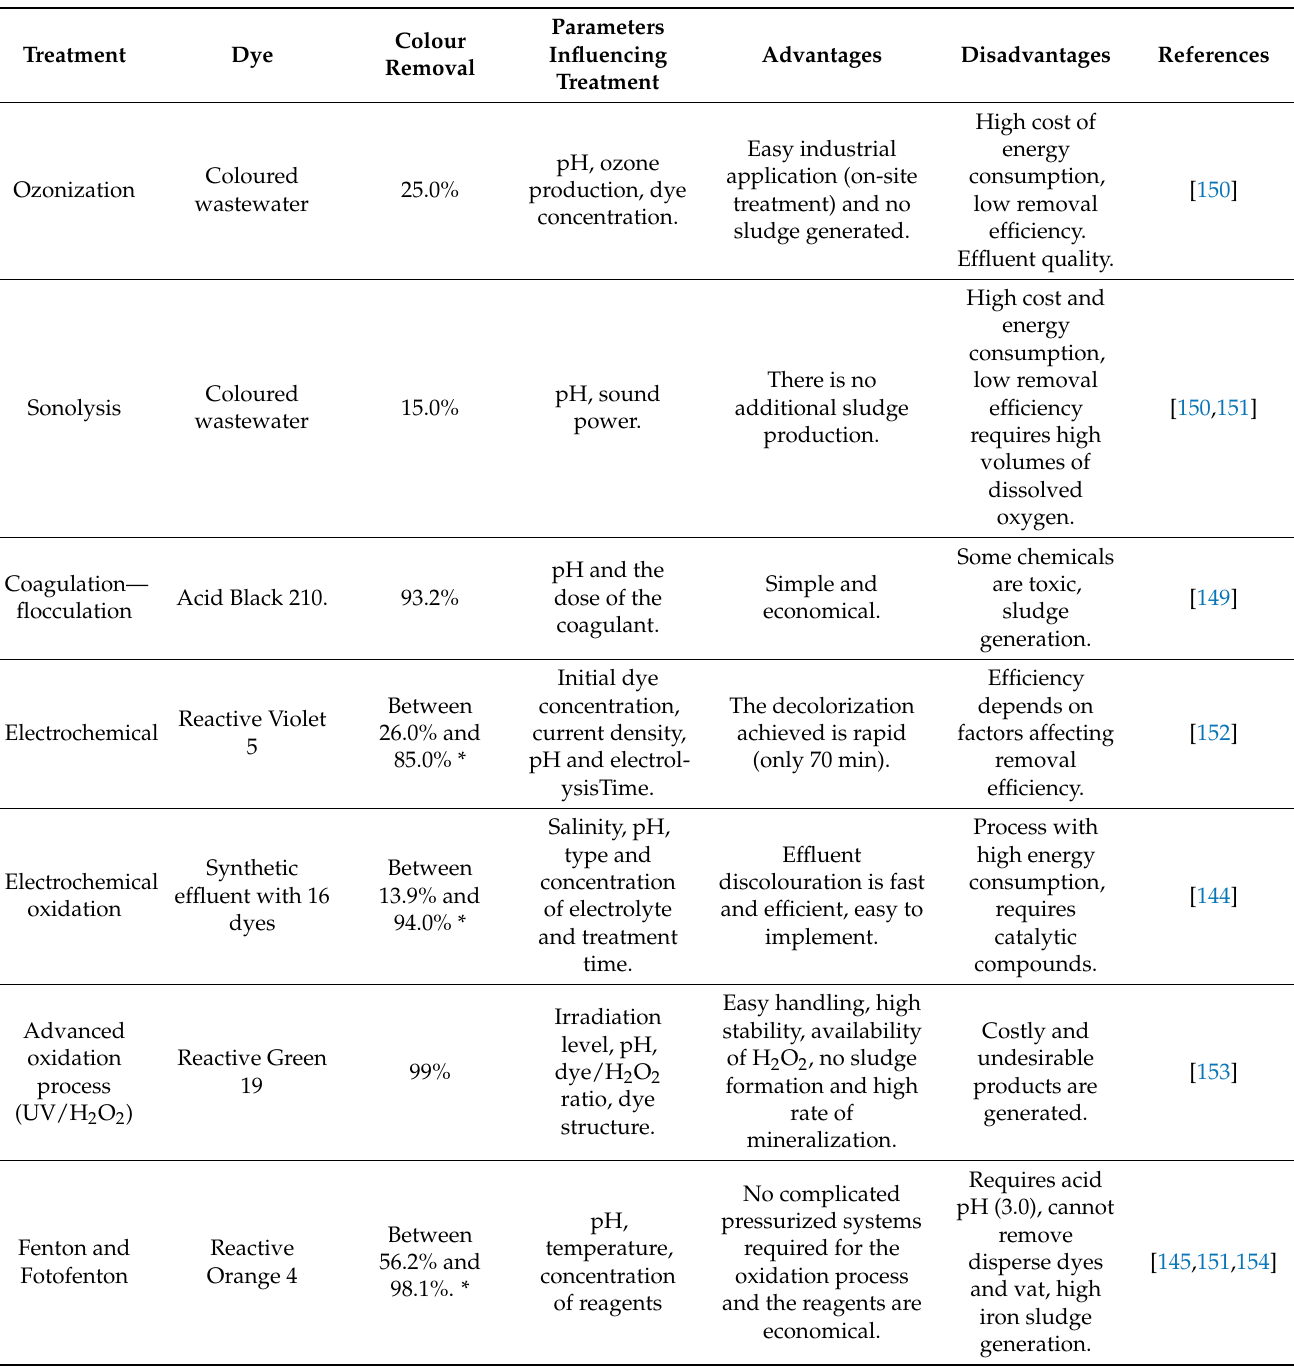
Table 5. Some chemical treatments used in the removal of